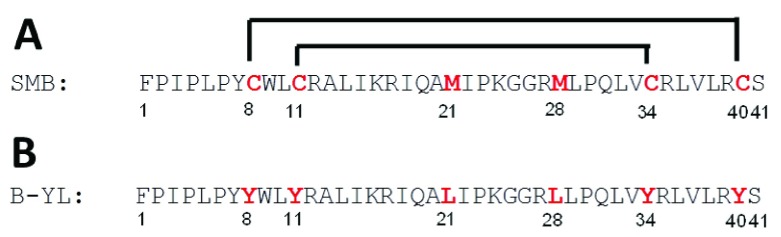
Sequences for Super Mini-B (SMB) and B-YL.(
A) SMB (41 amino-acid residues; 1-letter amino-acid notation), with the N- and C-terminal Phe-1 and Ser-41 as indicated, as well as the sulfur-containing cysteines (Cys-8, Cys-11, Cys-34, Cys-40) and methionines (Met-21, Met-28) in red. The disulfide-linkages are shown between Cys-11 and Cys-34 and between Cys-8 and Cys-40. (
B) B-YL (41 residues) shares the same sequence as its parent SMB, except that the cysteines and methionines are replaced by tyrosines (Tyr-8, Tyr-11, Tyr-34, Tyr-40) and leucines (Leu-21, Leu-28) in red, respectively.